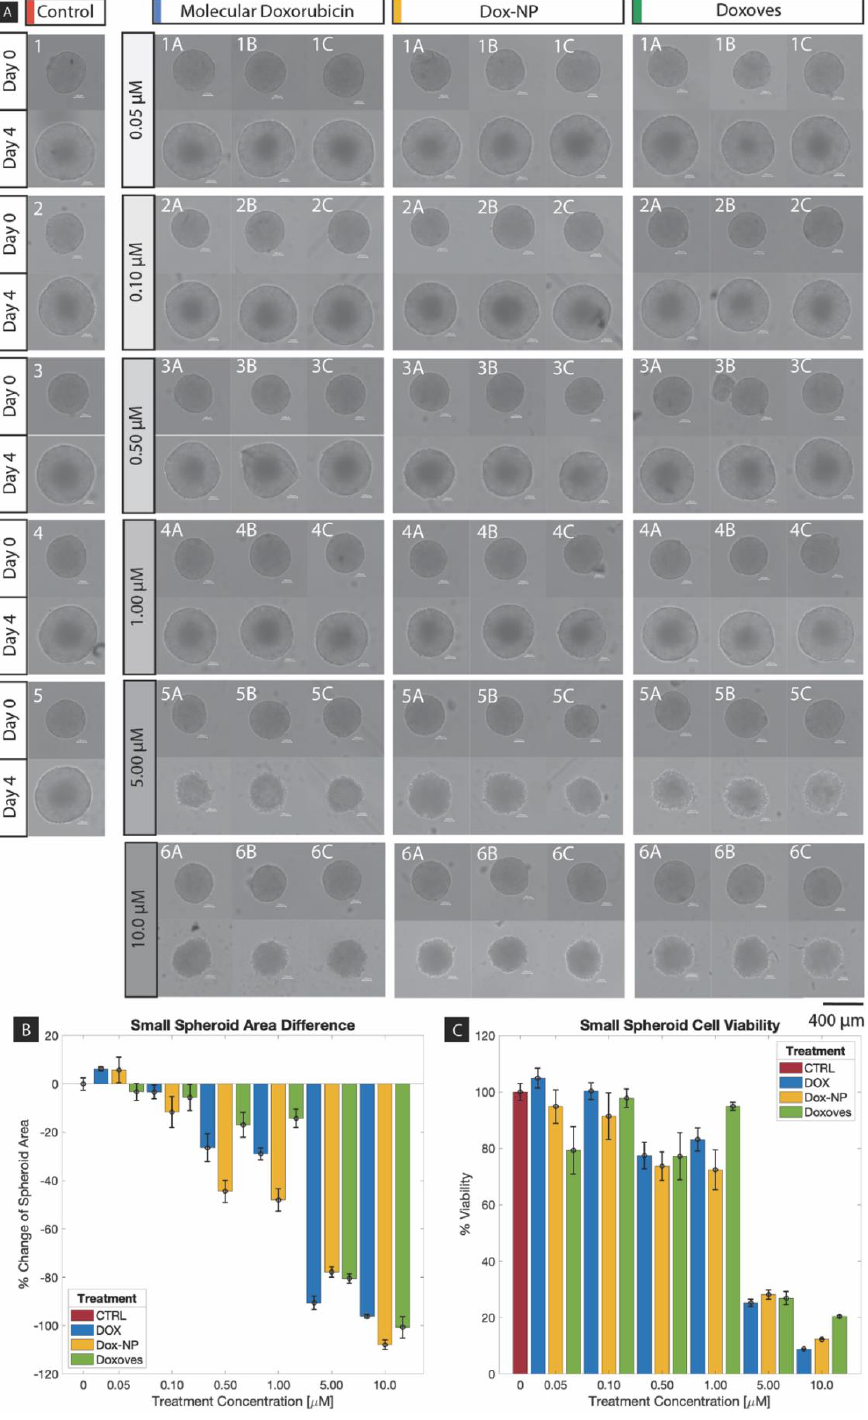
Figure 4. Small spheroid ( A ) Brightfield images of chemotherapeutic response, ( B ) percent change in area, and ( C ) percent viability. area, and ( C ) percent